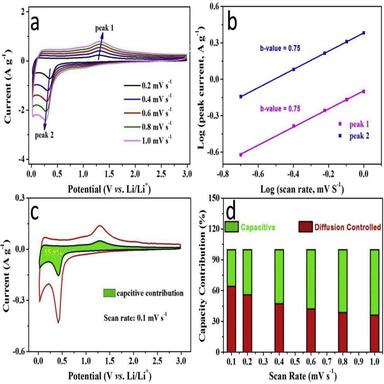
Kinetics analysis of the Li-storage behavior for the CNT@MnO@NC electrode: (a) scan rate-dependent CV profiles from 0.2 to 1.0 mV s-1 , (b) the relevant log(i) vs. log(v) plots for cathodic/anodic peaks, (c) The capacitive contribution (green lines) calculated from CV profile under a scan rate of 0.1 mV s-1 , (d) contribution ratio of capacitive charge-storage (green) and diffusion-controlled insertion (red) mechanism towards the fresh cell with varied scan rates. (For interpretation of the references to co